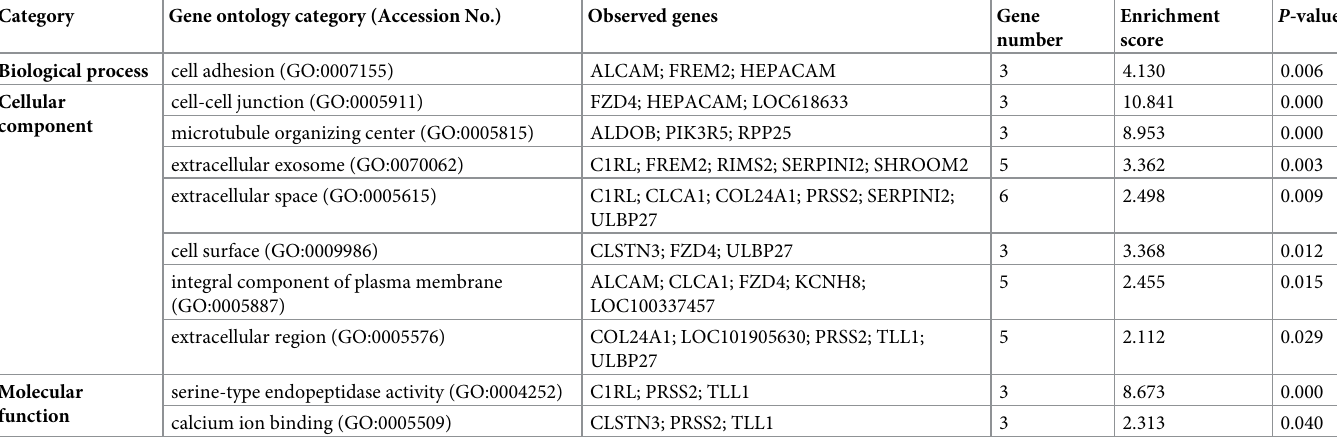
Table 5. Gene ontology analysis of differentially expressed genes in rumen epithelial of calves fed OP and SP. Category Gene ontology category (Accession